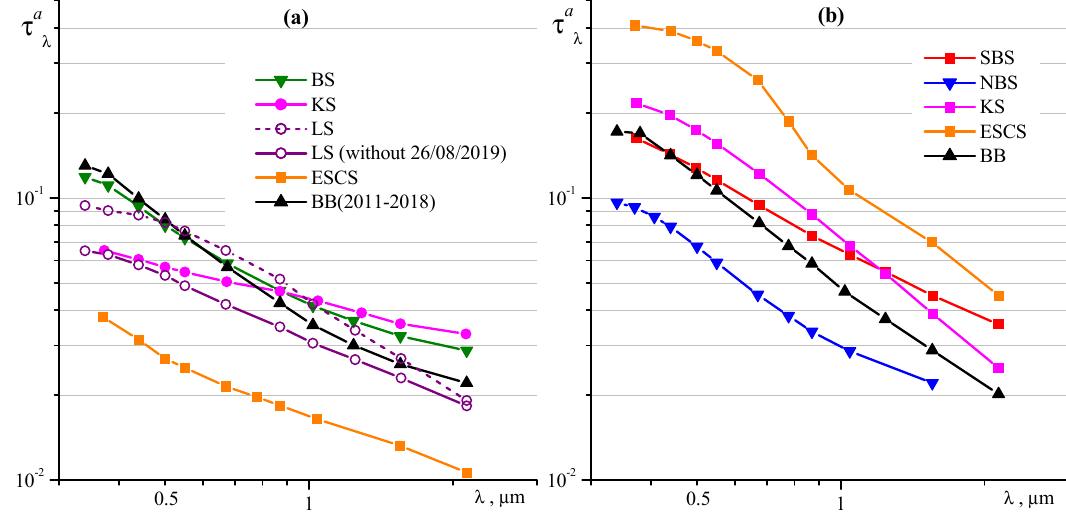
Figure 4. Average spectral dependences of AOD: ( a ) multiyear data in different regions of the Eurasian sector of the Arctic (BB/2011–2018 is Barentsburg); ( b ) measurements in 2019.